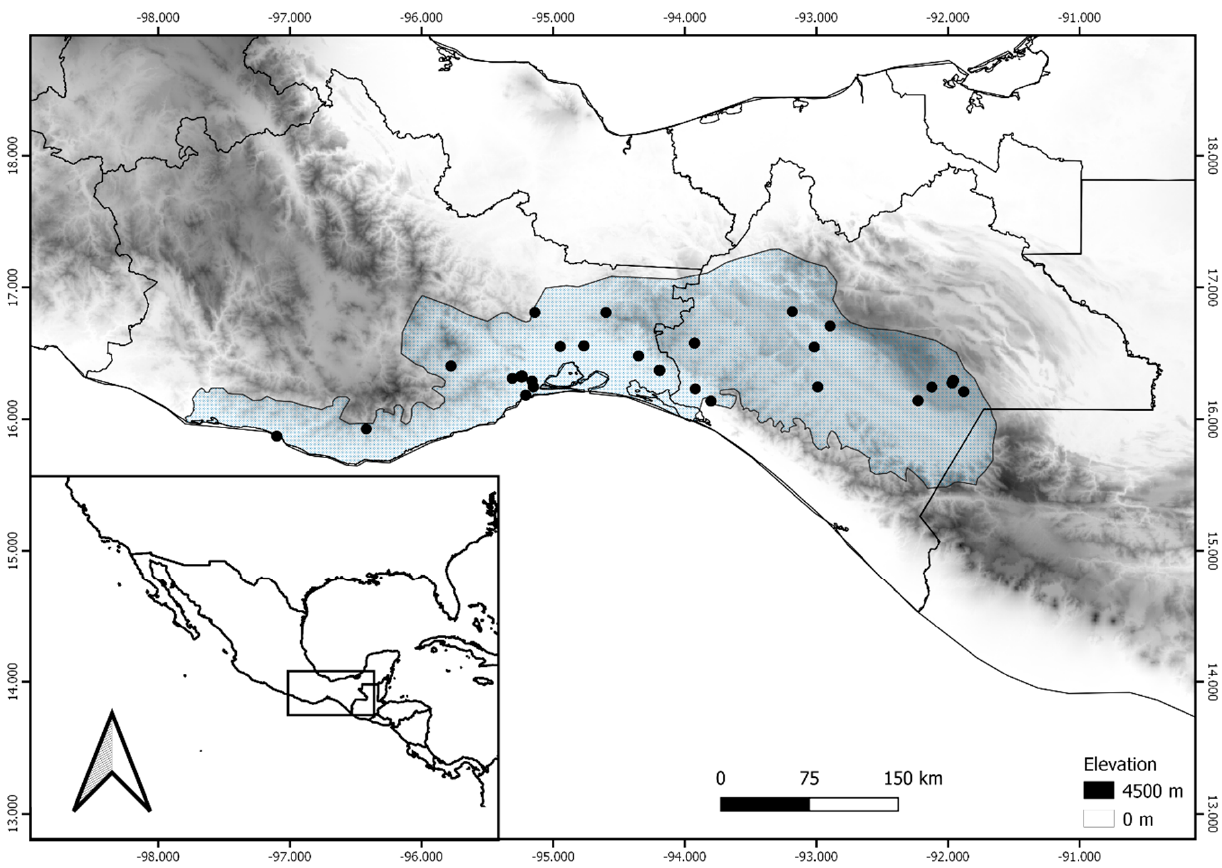
Figure 1. Collecting localities of specimens analyzed for the Tehuantepec Isthmus rattlesnake ( Crotalus ehecatl ) in southern Mexico. Black circles represent recorded localities, state boundaries are indicated by black lines, and the blue area represents the approximate distribution. The insert shows the position of the map in relation to Mexico.